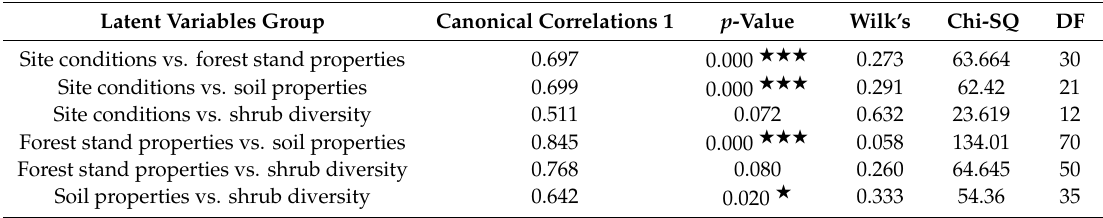
Table 2. The significance of paths between latent variables.